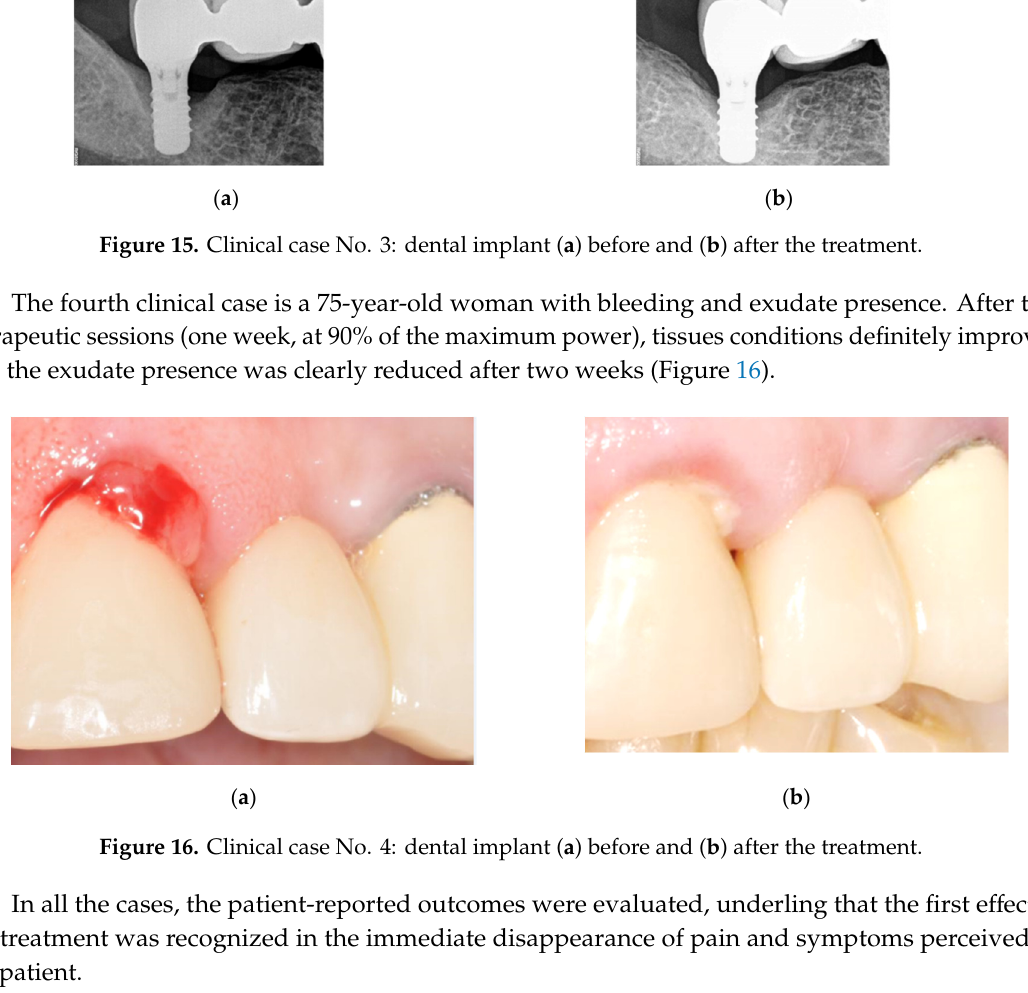
Figure 14. Clinical case No. 2: dental implant ( a ) before and ( b ) after the treatment.